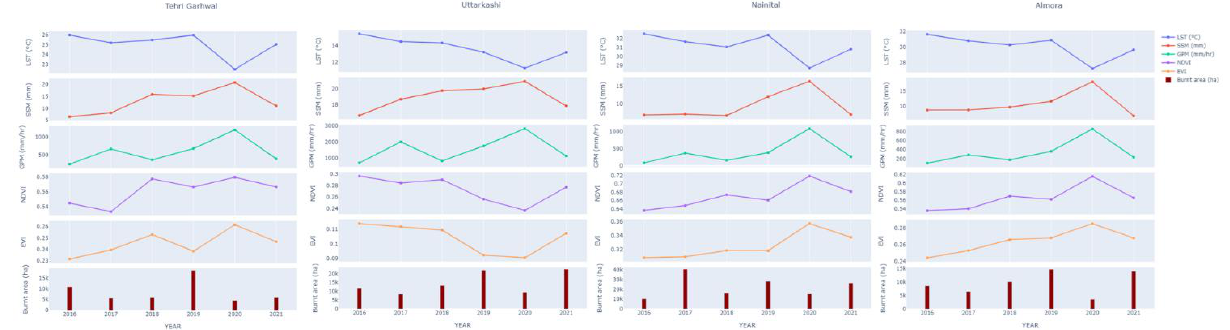
Figure 3. Spatio-temporal pattern of burnt area with the change in temperature, precipitation, NDVI, EVI and surface soil moisture